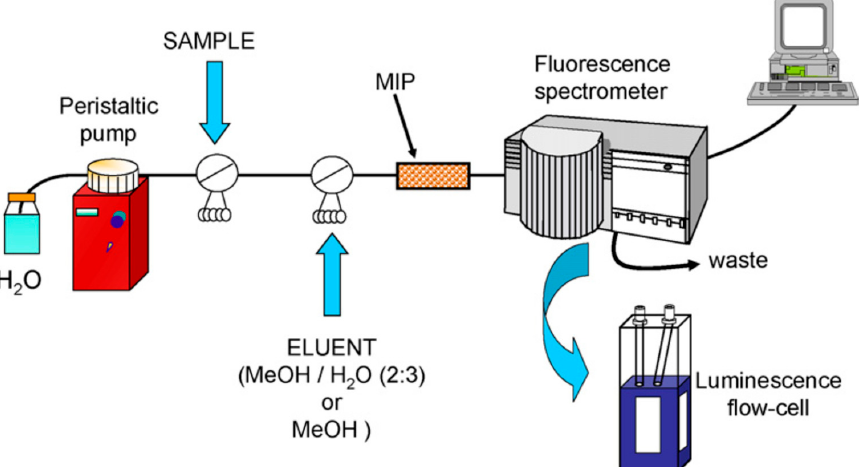
Figure 5. Optosensing manifold for the luminescent determination of the pesticide carbaryl. Reprinted from [36], with permission from Elsevier, 2007.